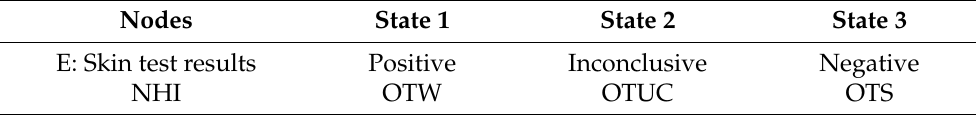
Table 2. Nodes and their states where NHI indicates new herd incidents, OTW indicates officially TB-free status withdrawn, OTUS indicates officially TB-free status unclassified and OTS indicates officially TB-free status